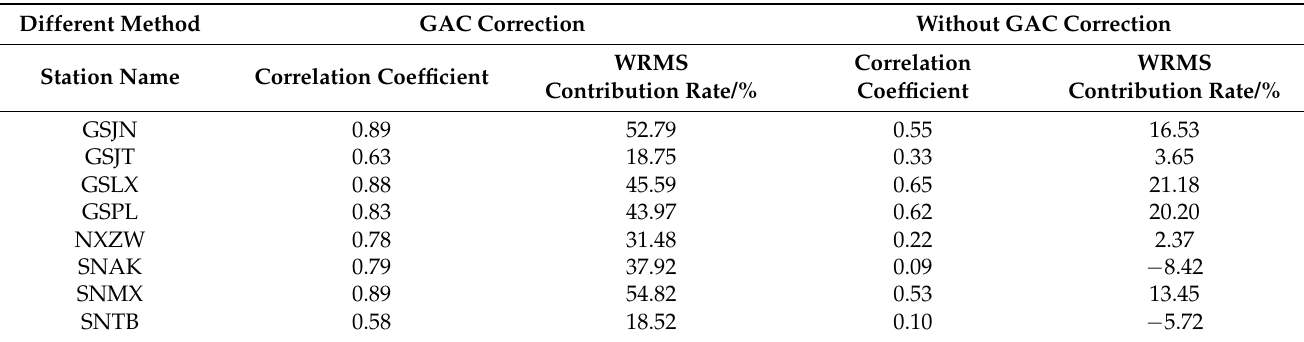
Table 3. Correlation coefficient and contribution rate between vertical time series from GNSS and load vertical deformation derived from GRACE in SGN from 2010 to 2014.